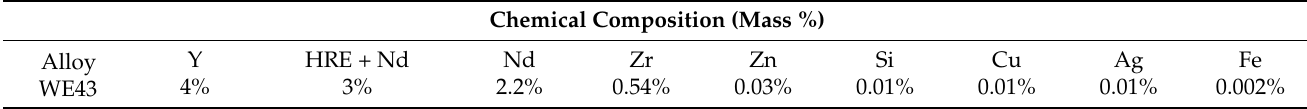
Table 1. Chemical composition of the WE43 alloy (mass %). Chemical Composition (Mass